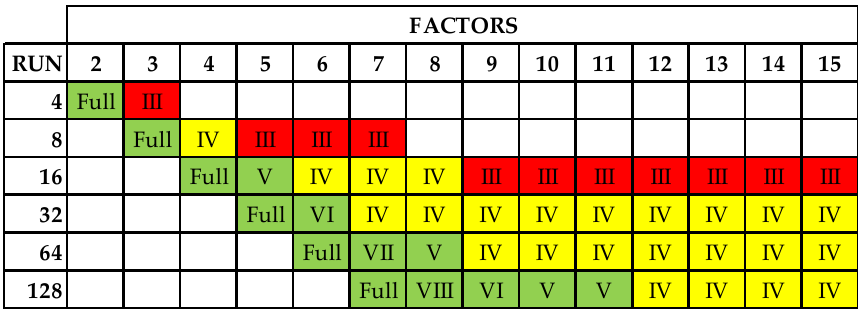
Table 4. Values of the design of experiments (DOE) factors.